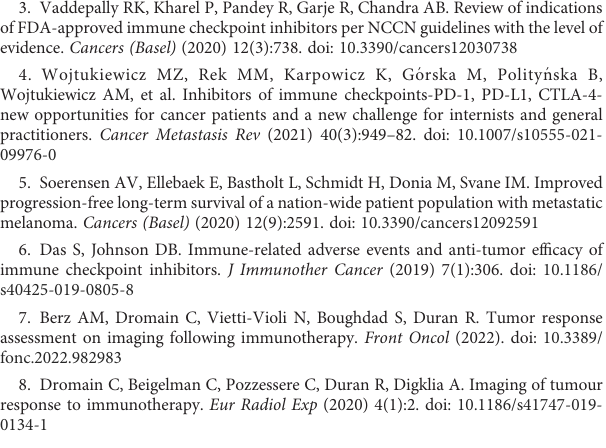
SUPPLEMENTARY FIGURE 1 “ Starry sky ” appearance. Small echogenic foci representing portal triads and portal venous walls (stars; arrows) can be seen throughout a diffusely hypoechogenic liver parenchyma (sky). This pattern, although non-speci fi c, can be seen with